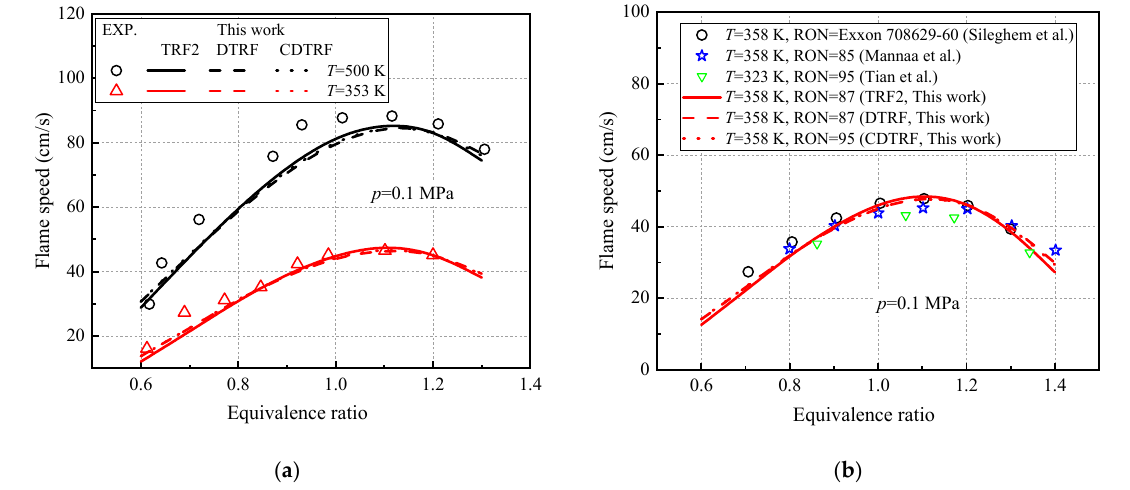
Figure 16. Comparison of laminar flame speed experiment [12,31,50,51] and model calculation of real gasoline. ( a ) Experiment date measured by Zhao et al. [50] at two temperatures of 353 and 500 K. and ( b ) Experiment date measured by Sileghem et al. [31], Mannaa et al. [12], and Tian et al. [51].